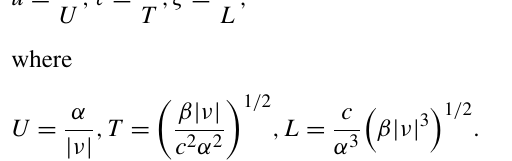
Fig. 3b. As the initial solitary wave decays, the trailing ra- diation itself steepens to form a group of solitary-like waves that also decay by radiation damping. Over larger distances,